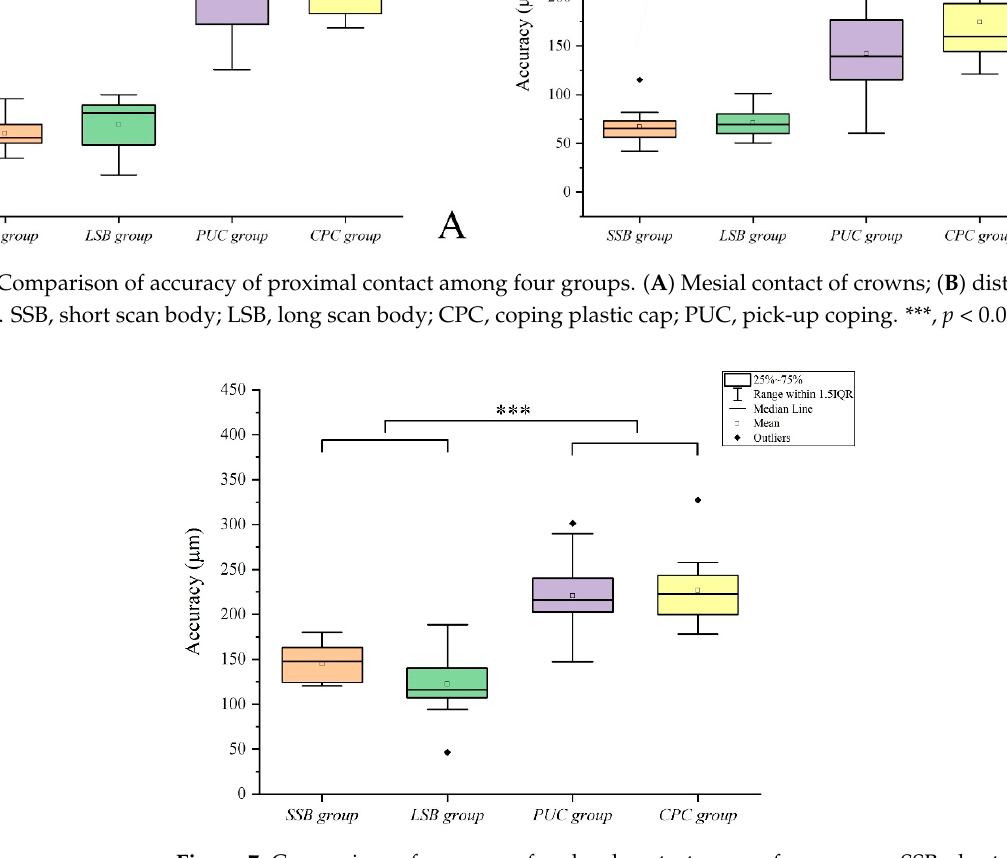
Table 2. Results of factorial ANOVA of ranks.